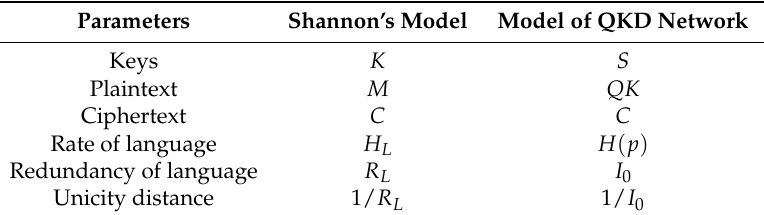
Table 1. The contrast between Shannon’s model and the model of the quantum key distribution (QKD) network. Parameters Shannon’s Model Model of QKD Network Keys